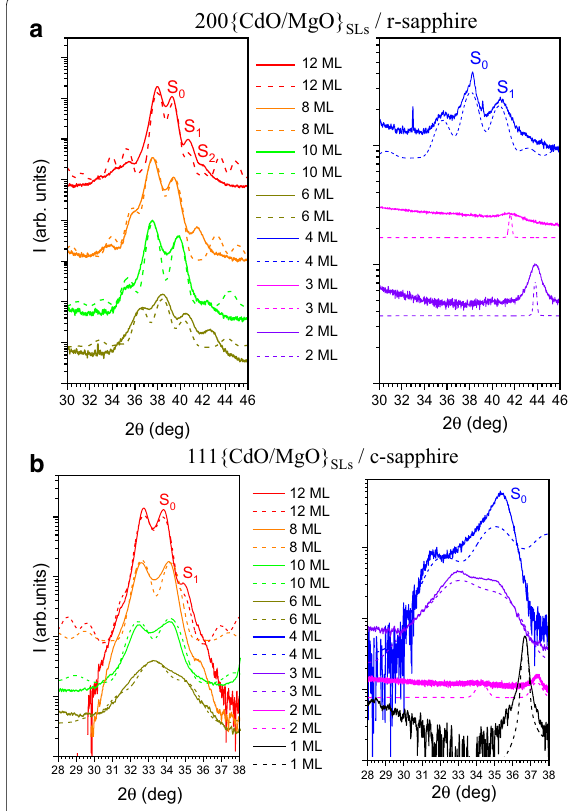
Fig. 2 2Theta–Omega of 200 {CdO/MgO} on r-Al 2 O 3 ( a ) and 111 {CdO/MgO} on c-Al 2 O 3 ( b ) XRD peaks of the series of SLs with different CdO layers thickness. Solid lines are the 2 θ / ω XRD scan measurement results and dash lines are 2 θ / ω XRD scan simulations. On the legend we mark the amount of CdO monolayers